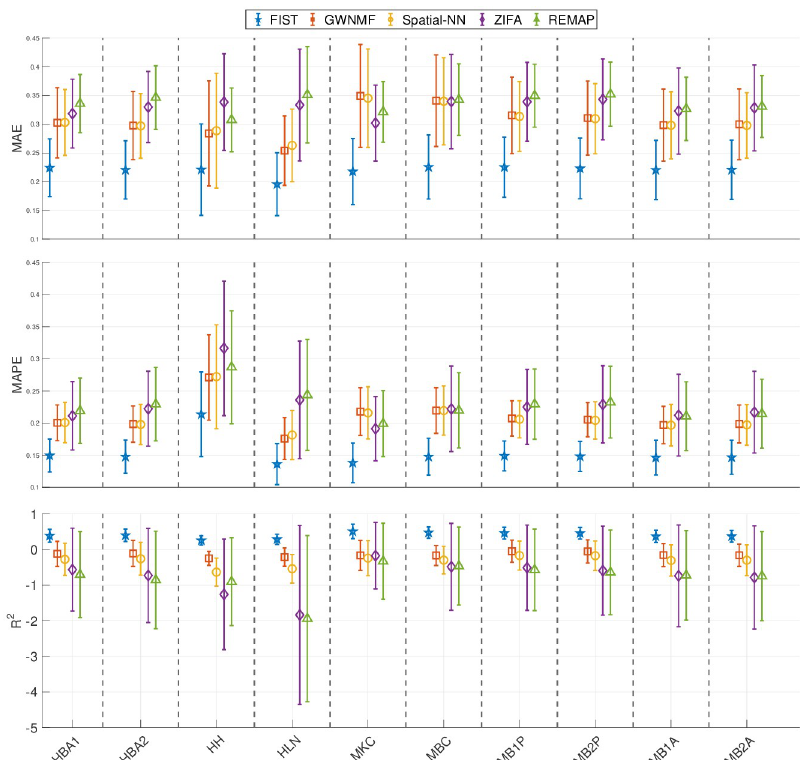
Fig 3. Gene-wise cross-validation on 10x Genomics data. The performances of the five compared methods on the 10 tissue sections are measured by 5-fold cross-validation. Each error bar shows the mean and variance of the imputation performance for one method on all the genes. The result on each of the 10 datasets is shown in one vertical column separated by dashed